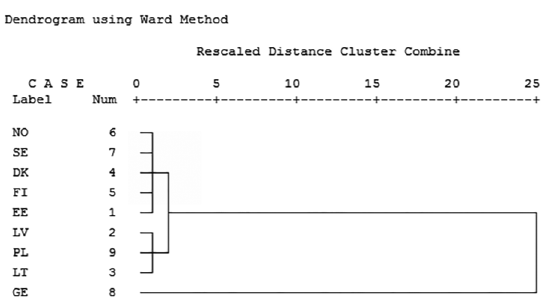
Fig. 11. Dendrogram representing the formation of